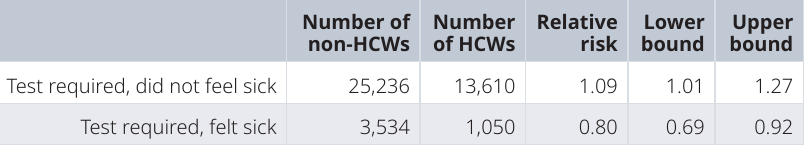
Table 4. Relative COVID-19 incidence rate (RR) and counts of healthcare workers and non-healthcare workers stratified by those who reported they felt/did not feel sick as an additional reason for getting